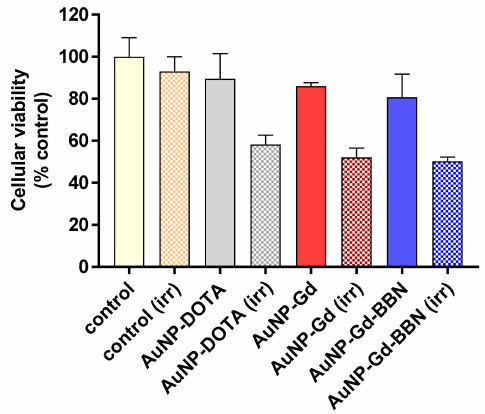
Figure 3. Cellular viability of PC3 cells treated with the di ff erent AuNPs (37.5 µ g / mL) and γ -irradiated at 2 Gy (total dose). Cellular viability was determined by the MTT assay, 72 h after irradiation. Results are expressed as mean ± SD (n =